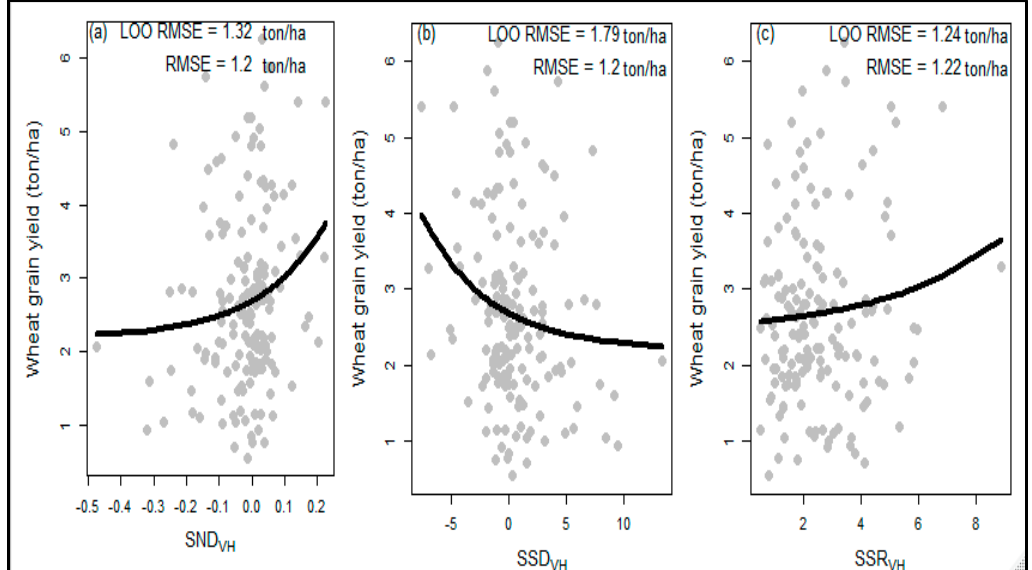
Figure 5. Scatter plots showing the non ‐ linear models for three indices using combined ‐ date VH polarization (db). Sub plots ( a ), ( b ), and ( c ) represent non ‐ linear model results of the SND, SSD, and SSR indices, respectively.